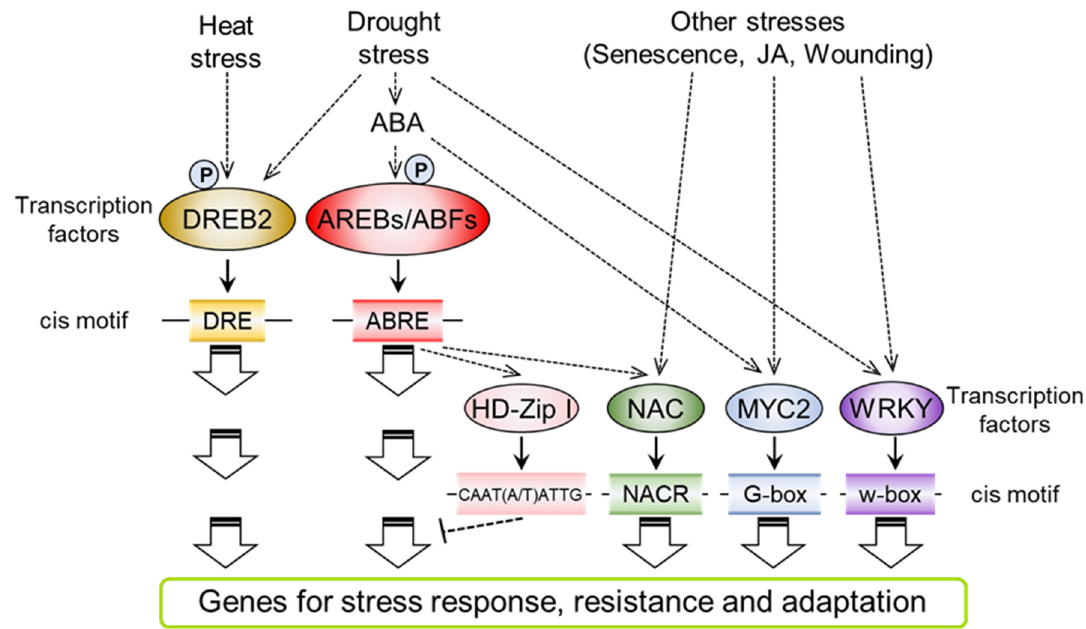
Figure 2. A schematic model of transcriptional regulatory networks under abiotic stress, including drought, heat and other stresses. The ellipsoids show transcription factors that mainly mediate drought stress and/or ABA responses. The oblong boxes indicate the cis motifs that exist in the promoter region of stress-induced genes. ABREs/ABFs function mainly in drought- and ABA-dependent pathways. DREB2 mediates ABA-independent and heat stress signals. Other transcription factors, including NAC, MYC2 and WRKY, mediate crosstalk signals between ABA and other stresses in